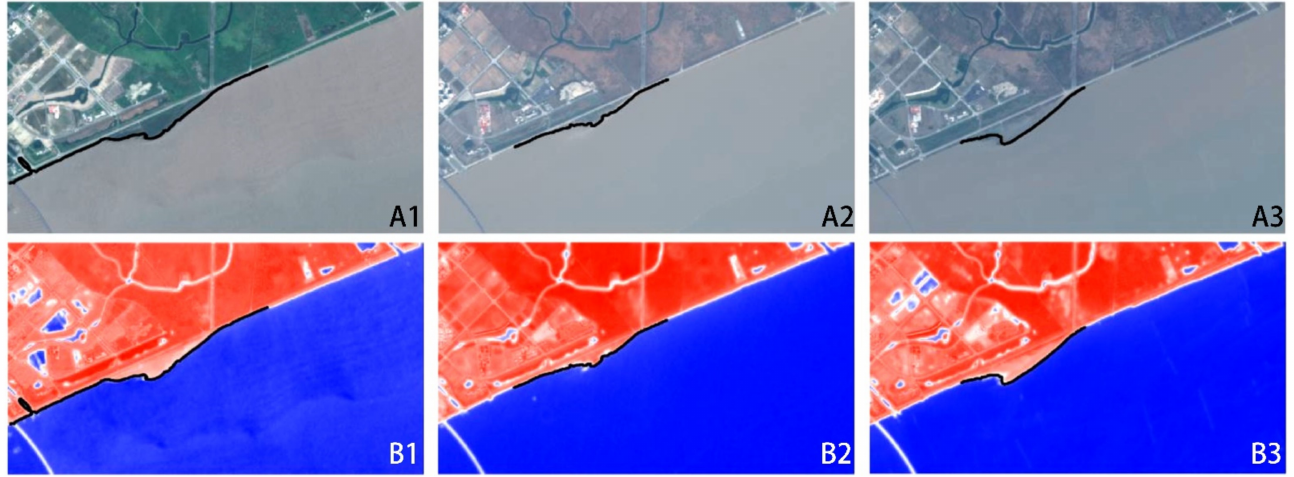
Figure 5. The selected outputs of CoastSat. ( A1 – A3 ) are the original satellite images at three different moments; ( B1 – B3 ) are the results of MNDWI . Red and blue regions represent the land and water, respectively. The black solid lines are the waterlines calculated using this